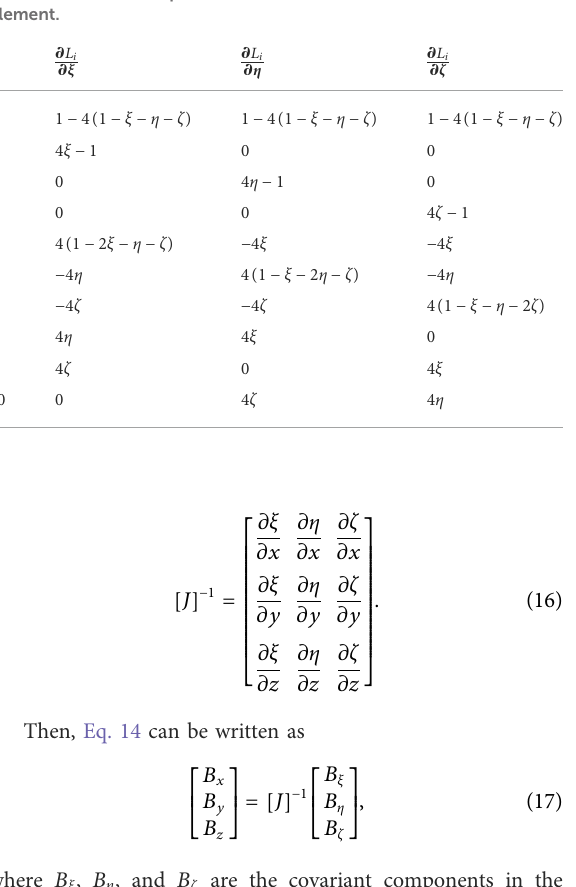
TABLE 1 Functions required for the Jacobian: second order curved